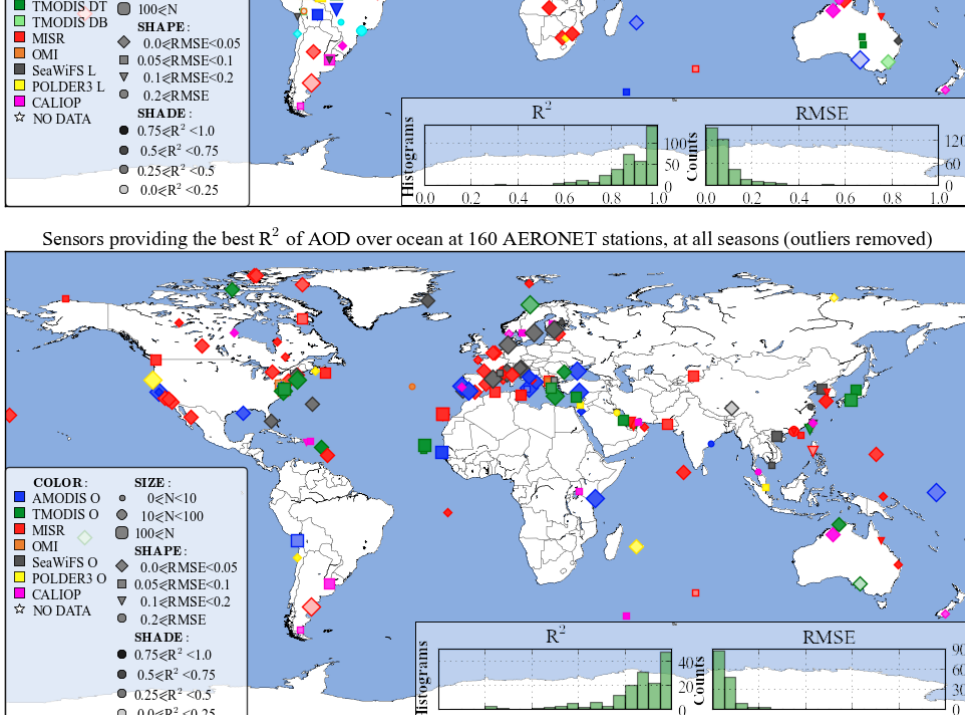
Fig. 11. Spaceborne datasets with the best correlation ( R 2 ) of the retrieved AOD with the AOD measured by each individual inland (top) and coastal or island-based (bottom) AERONET site. The intensity of marker shading indicates the degree of correlation. Marker shape indicates the range of root mean square error (RMSE) associated with the displayed best R 2 . Finally, marker size corresponds to the number of collocated data points used to compute the displayed statistics. Histograms in the bottom insets highlight the distribution of these statistics over all sites based on bins of 0.05 AOD. The statistics were calculated based on the data that were pre-filtered by QA and screened of outliers as described in Sects. 4 and 5.